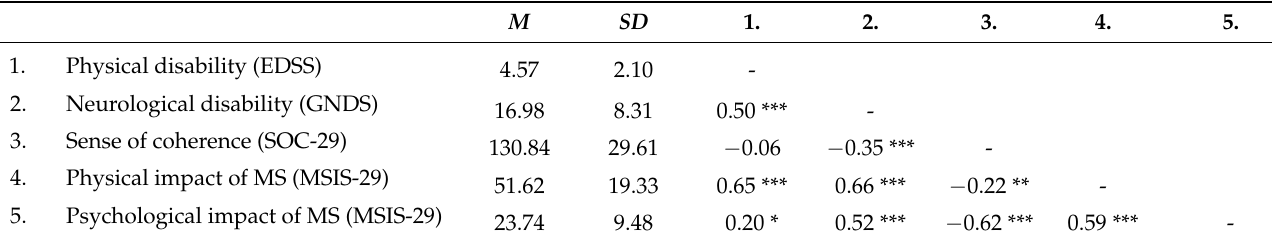
Table 4. Results of the Pearson’s r correlation.